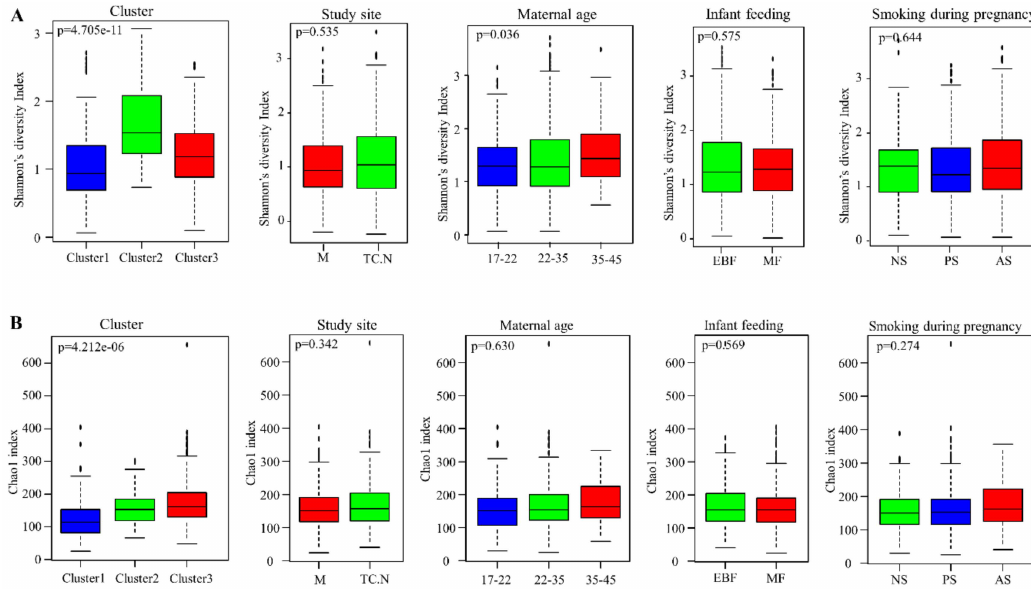
Figure 4. Alpha diversity indices of human breast milk bacteriome profiles. ( A ) Shannon diversity index, and ( B ) Chao1 index of HBM bacteriome profiles of participants based on